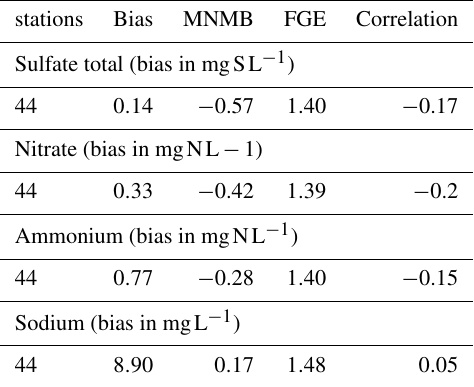
Table 9. Statistics of the comparison between the MOCAGE simu- lation and the EMEP wet deposition measurements database for the year